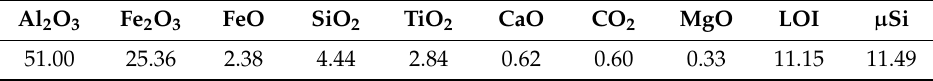
Table 1. The chemical composition of Middle-Timan bauxite, wt.